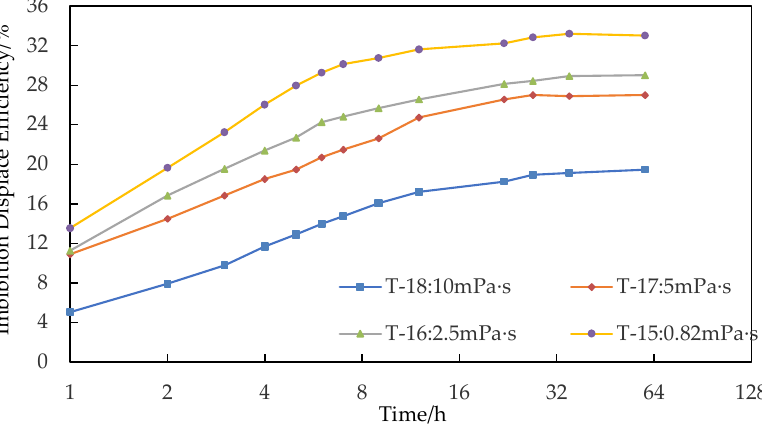
Figure 8. Displacement efficiency curve of imbibition for investigating the viscosity of crude oil.